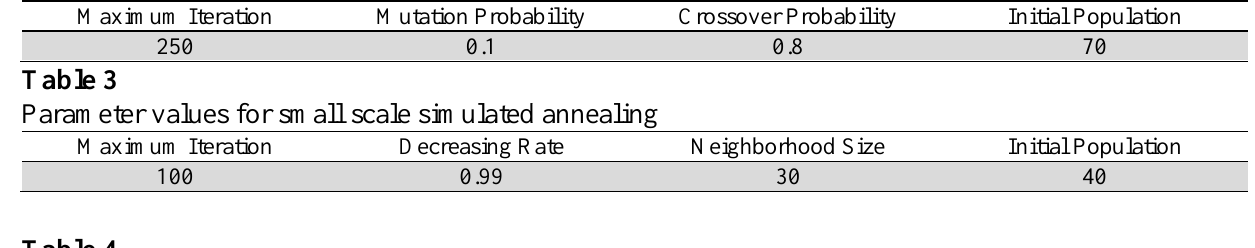
Parameter values for large scale simulated annealing Maximum Iteration